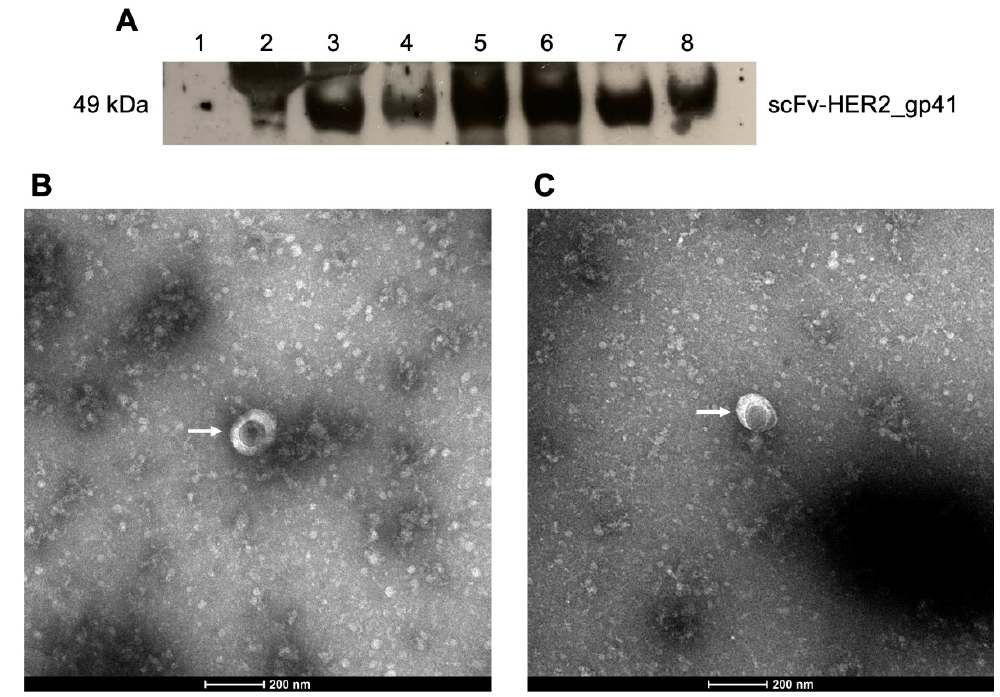
Figure 4. Characterization of HER2-specific HIV-1-based VLPs produced with pX1665, pMDLg/pRRE and pRSV-REV in HEK-293T cells plated at a density of 1.0 × 10 6 cells/well on 6-well plates and collected 48 h post-transfection. ( A ) Western Blot of the VLPs. Lane 1: negative control (extract lacking HA); Lane 2: positive control (extract containing HA); Lanes 3, 4, 5, 6, 7 and 8: Different VLP batches. Western Blot detection was performed using an anti-HA monoclonal antibody (1:2000) and an anti-mouse secondary antibody (1:3000). Visualization of the bands was performed with the ECL ® reagent. All the VLP batches display the HA-tagged scFv-HER2_gp41 fusion protein. ( B ) TEM image of a HIV-1 Gag VLP (depicted by a white arrow). Scale bar = 200 nm. ( C ) TEM image of a HER2-specific HIV-1 VLP (depicted by a white arrow). Scale bar = 200 nm.